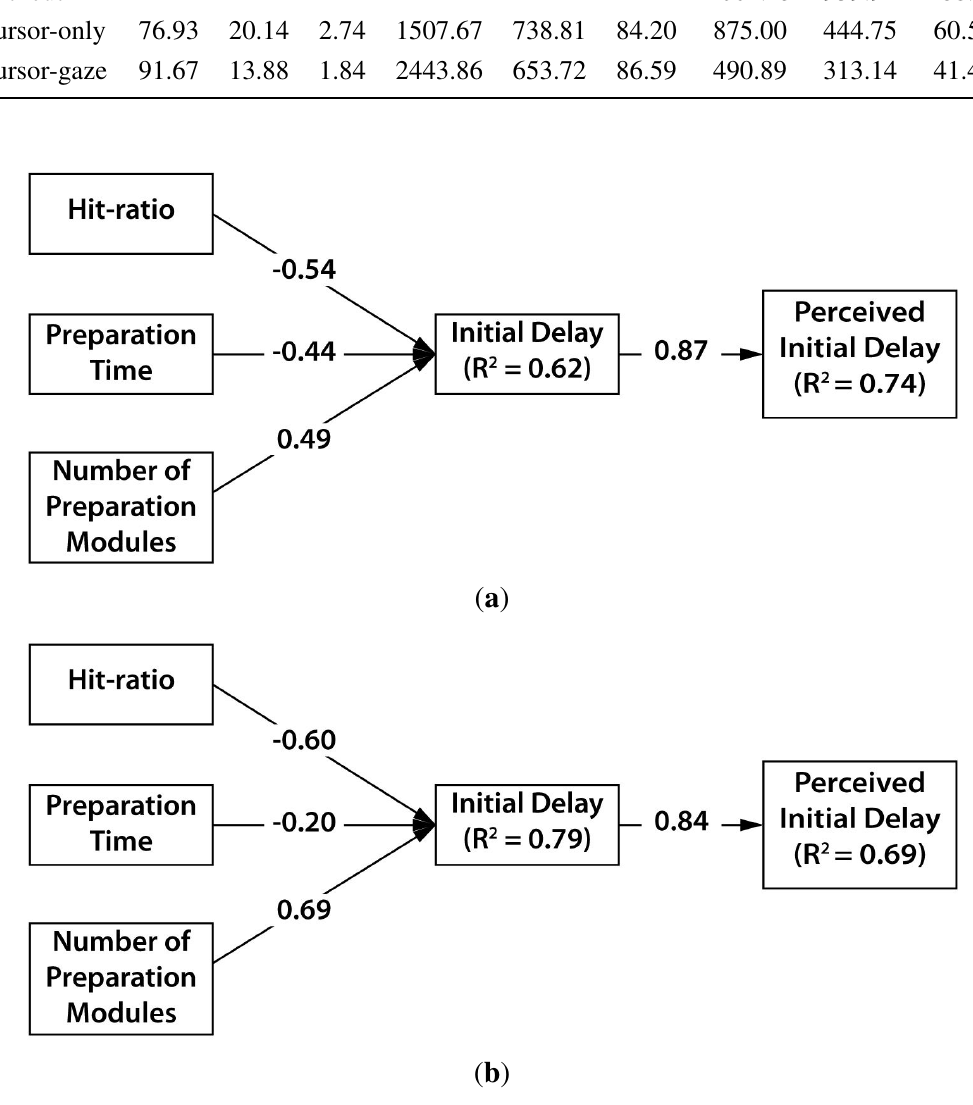
Figure 13. ( a ) Structural model of the cursor-only method; ( b ) structural model of the cursor-gaze